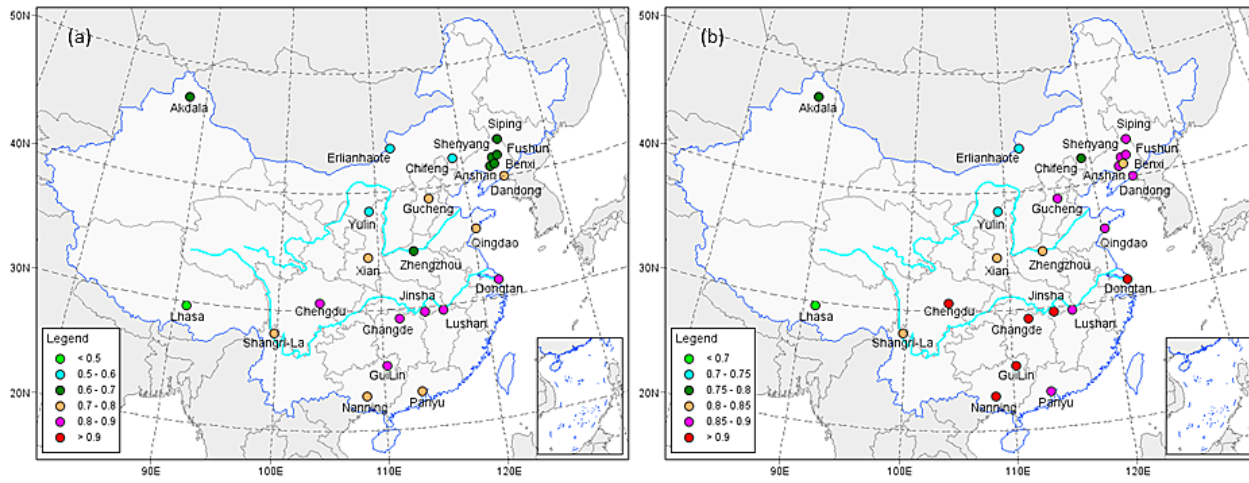
Figure 3. Spatial distribution of the average ratios of (a) PM 2 . 5 / PM 10 and (b) PM 1 / PM 2 . 5